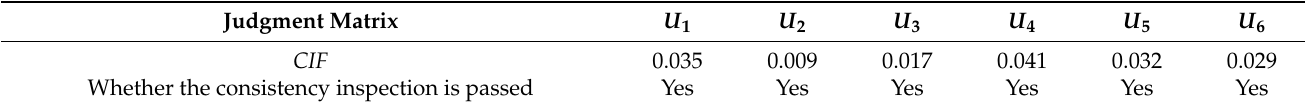
Table 3. Consistency calculation results of the judgment